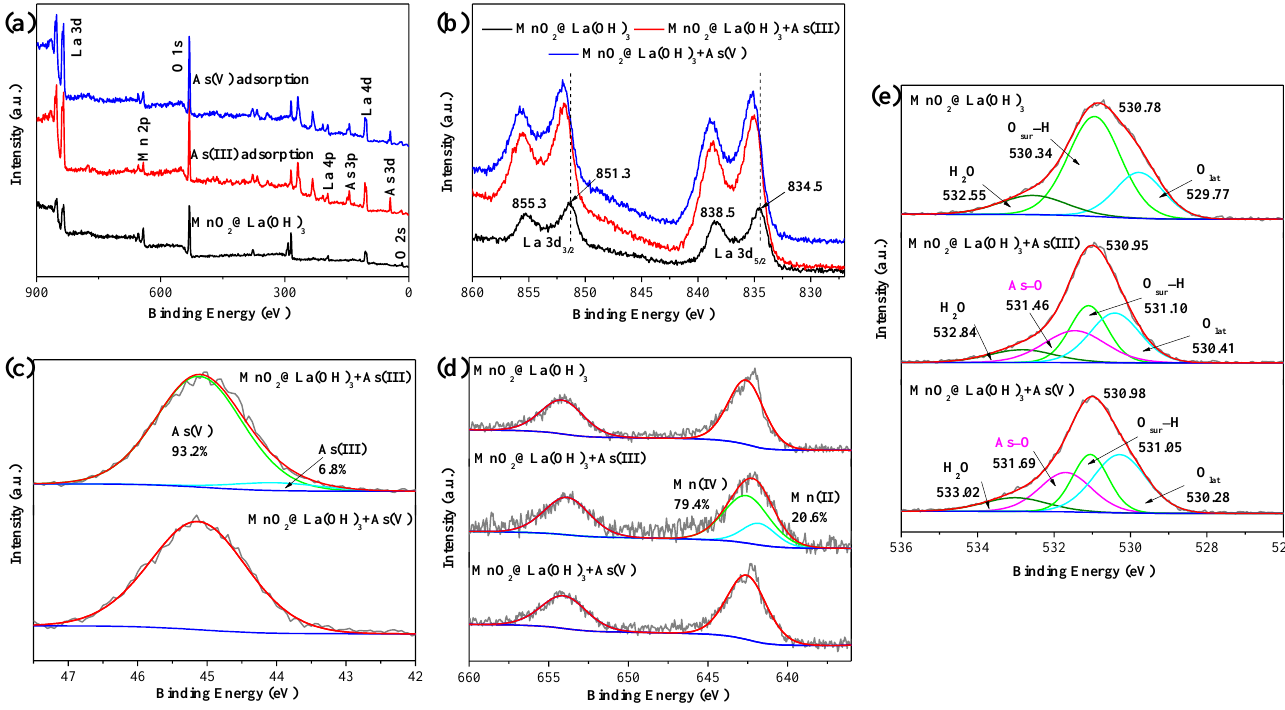
Figure 7. XPS analyses of MnO 2 @La(OH) 3 nanocomposite before and after arsenic removal at pH 4.0. Full spectra ( a ), La 3d ( b ), As 3d ( c ), Mn 2p ( d ) and O 1s ( e ) high-resolution XPS spectra. The high-resolution XPS scans of O 1s spectra of the MnO 2 @La(OH) 3 nanocomposite